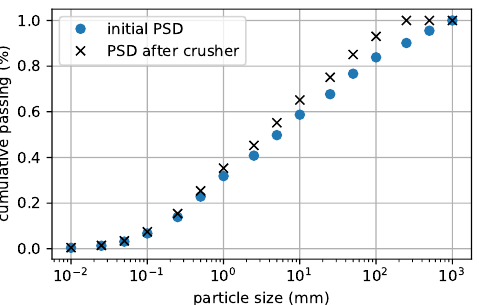
Figure 5. The cumulative particle size distribution (PSD) after blasting and after the